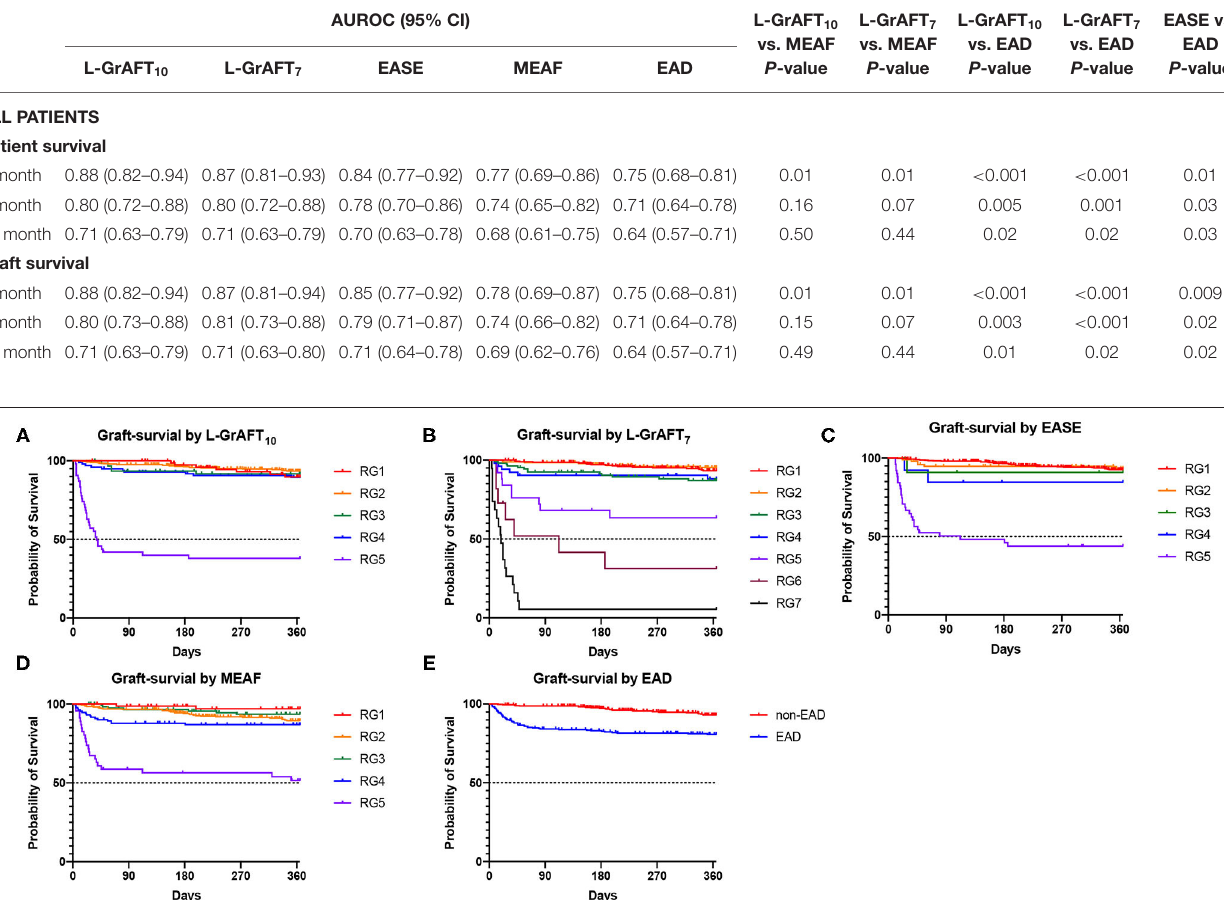
Frontiers in Surgery |